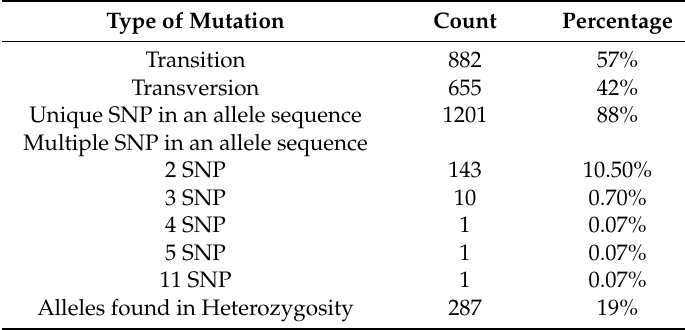
Table 4. General characteristics of single-nucleotide polymorphism (SNP) data for 1537 alternative alleles found in six Notopteridae species.